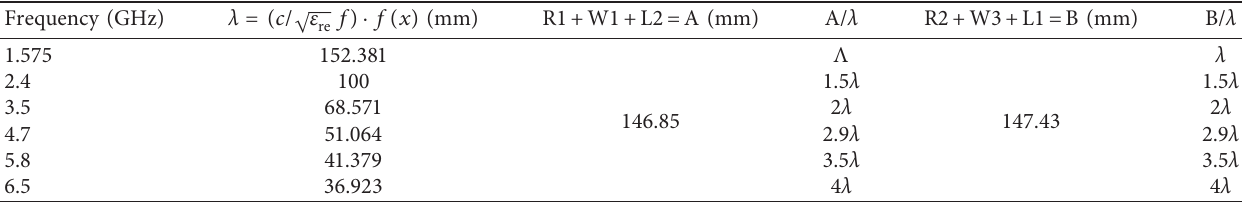
Table 2: Comparison table of wavelength and relative equilateral right triangle slot path length.